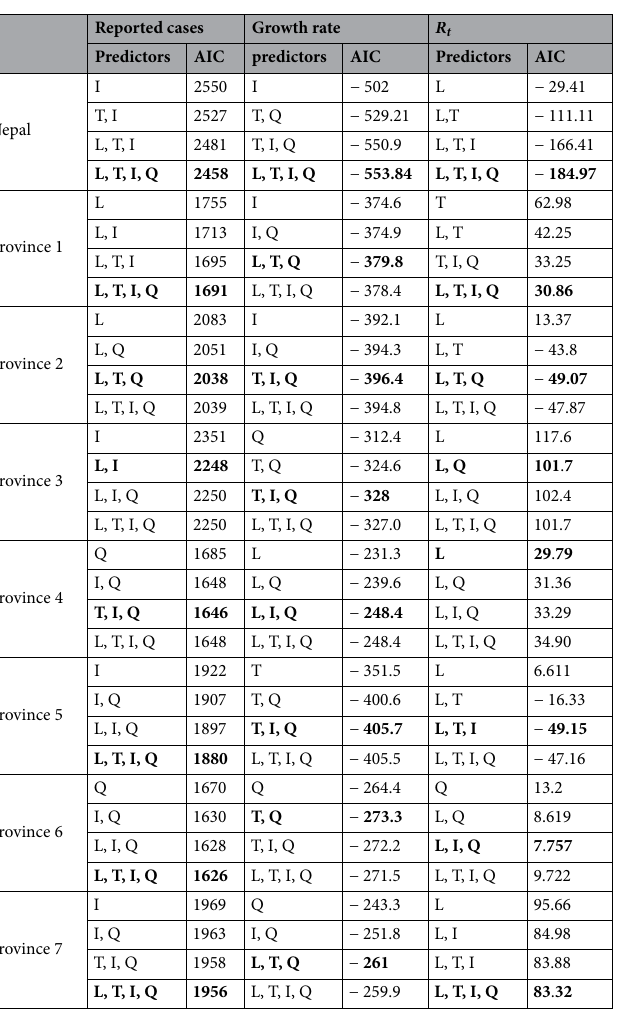
Table 3. The models having the lowest AIC values for three response variables (the reported cases, the daily growth rate, and the basic reproduction number), with four predictors (L-lockdown, T-testing, I-isolation, and Q- quarantine) taken 1, 2, 3, and 4 at a time. The bold-face indicates the best model identified according to AIC values for each province and the whole